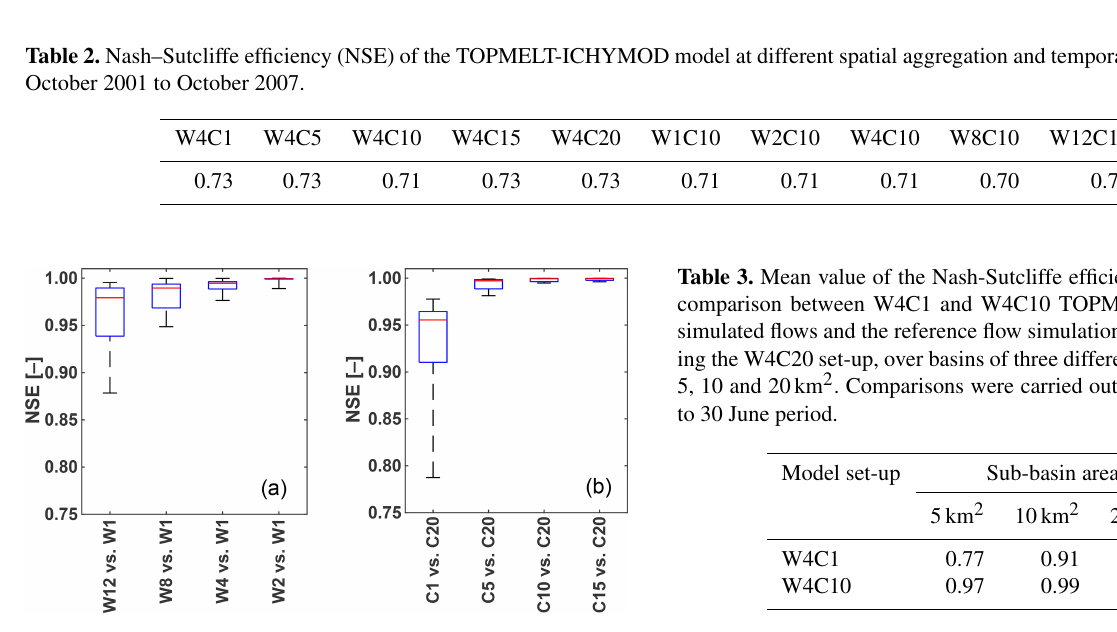
Figure 7. Box plots of NSE computed from the pixel-by-pixel com- parison of the (a) temporal and (b) spatial aggregation series of w.e. maps, from October 2010 to 30 June 2011 at a weekly time step. On each box, the central mark indicates the median, and the bottom and top edges of the box indicate the 25th and 75th percentiles, re- spectively. The whiskers extend to the maximum and the minimum efficiency. The reference is TOPMELT with W1-C10 configuration for (a) and W4-C20 for (b) .